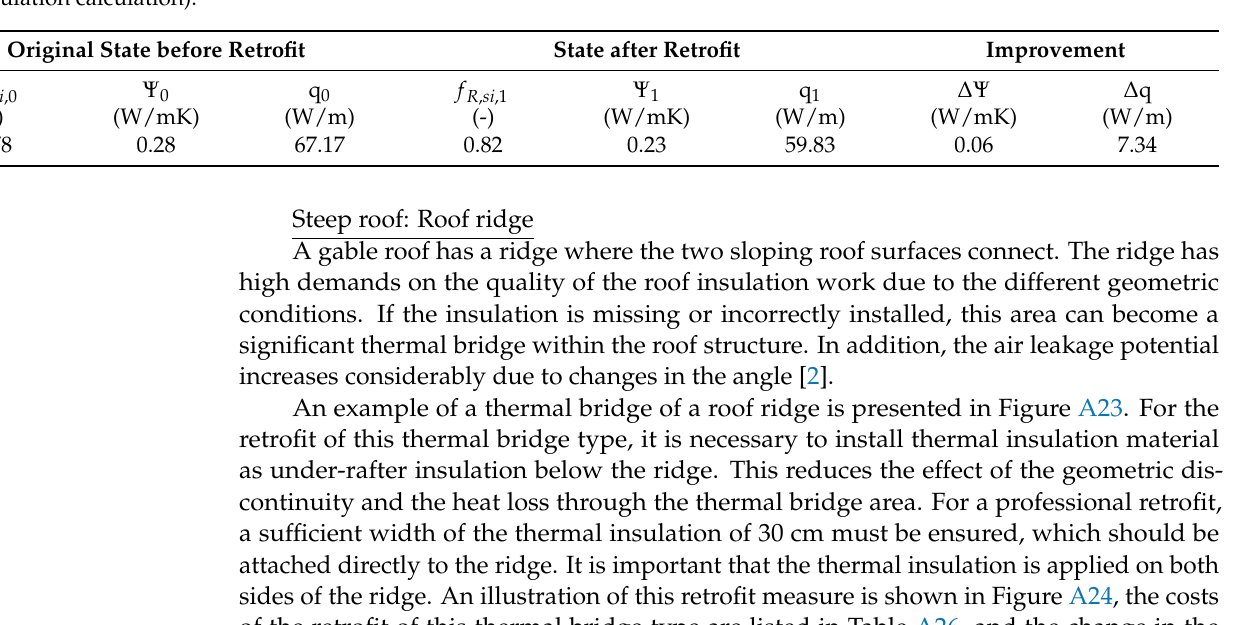
Table A25. Quantifiable results of the thermal bridge retrofit of a staggered story (ThermCad thermal bridge simulation